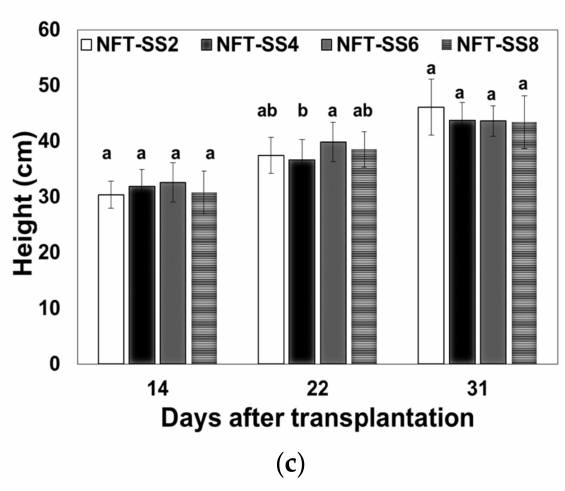
Figure 3. Mean height (cm) of basil irrigated by means of ( a ) G-NS or ( b ) G-SS during the first period and ( c ) NFT-SS during the second period. Means followed by different lowercase letters (a, b) differ significantly according to the Tukey–Kramer HSD test at p < 0.05 across the fertigation